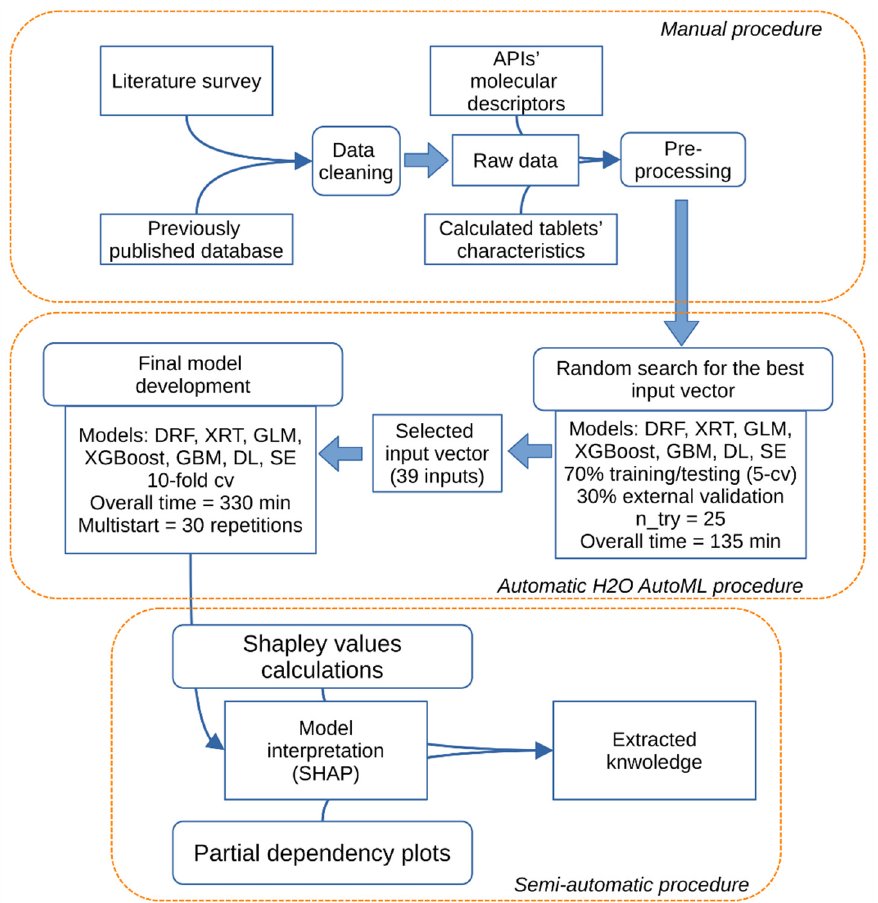
Figure 1. Schematic representation of the applied workflow. Models: distributed random forest (DRF), extremely randomized trees (XRT), generalized linear model (GLM), extreme gradient boosting machine (XGBoost), gradient boosting machine (GBM), deep learning (fully connected multilayer artificial neural network, DL), and stacked ensemble (SE); n_try, number of starting points for probing hyperparameter space; cv, cross-validation; API, active pharmaceutical ingredi- ent.